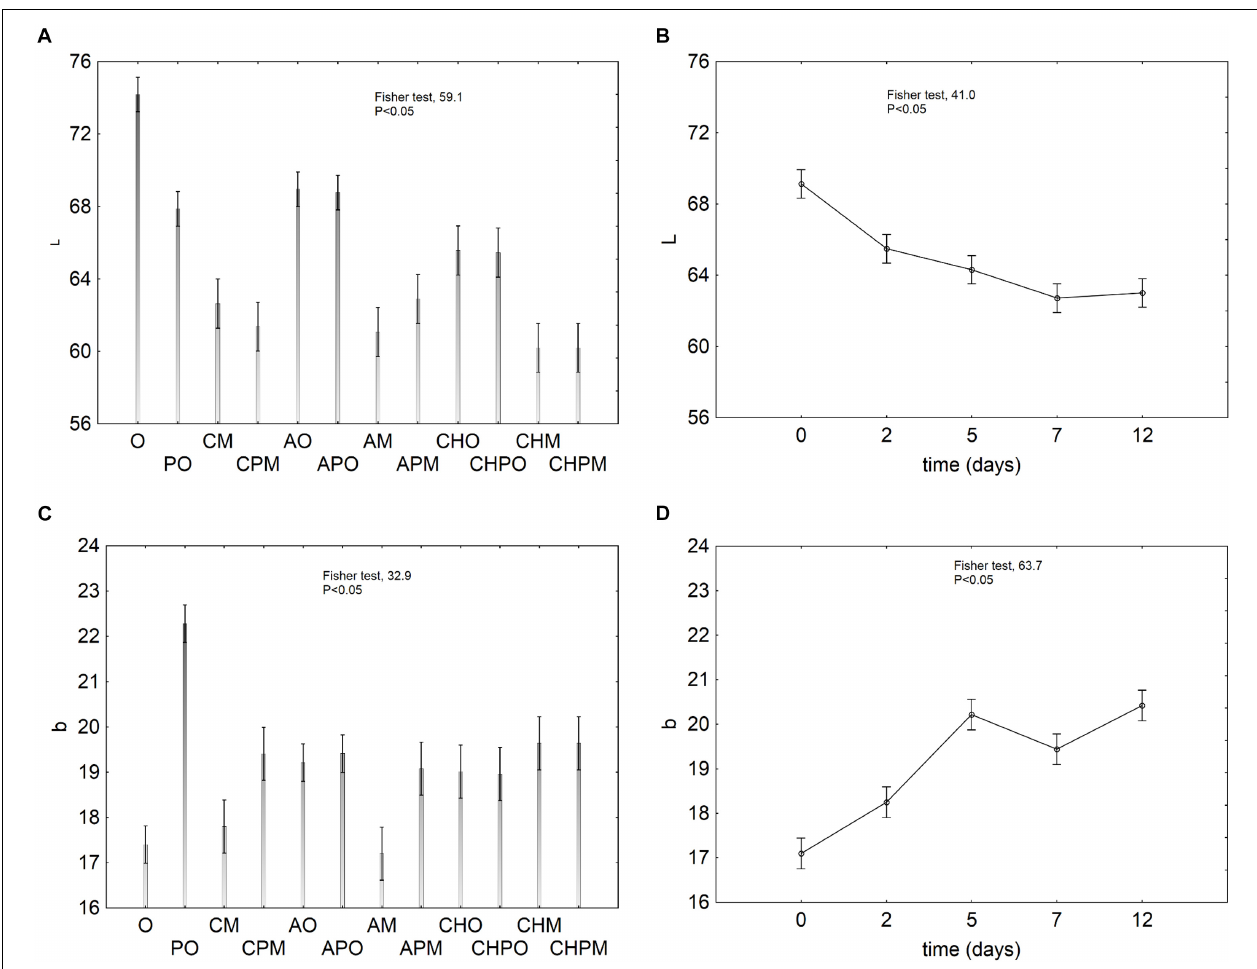
FIGURE 3 | Decomposition of the statistical hypothesis for the effect of the kind of treatment and the storage time on the instrumental color. Vertical bars denote 95% confidence intervals. For the acronyms of samples see Materials and Methods. (A) effect of the treatment on L; (B) effect of the storage time on L; (C) effect of the treatment on b; (D) effect of the storage time on